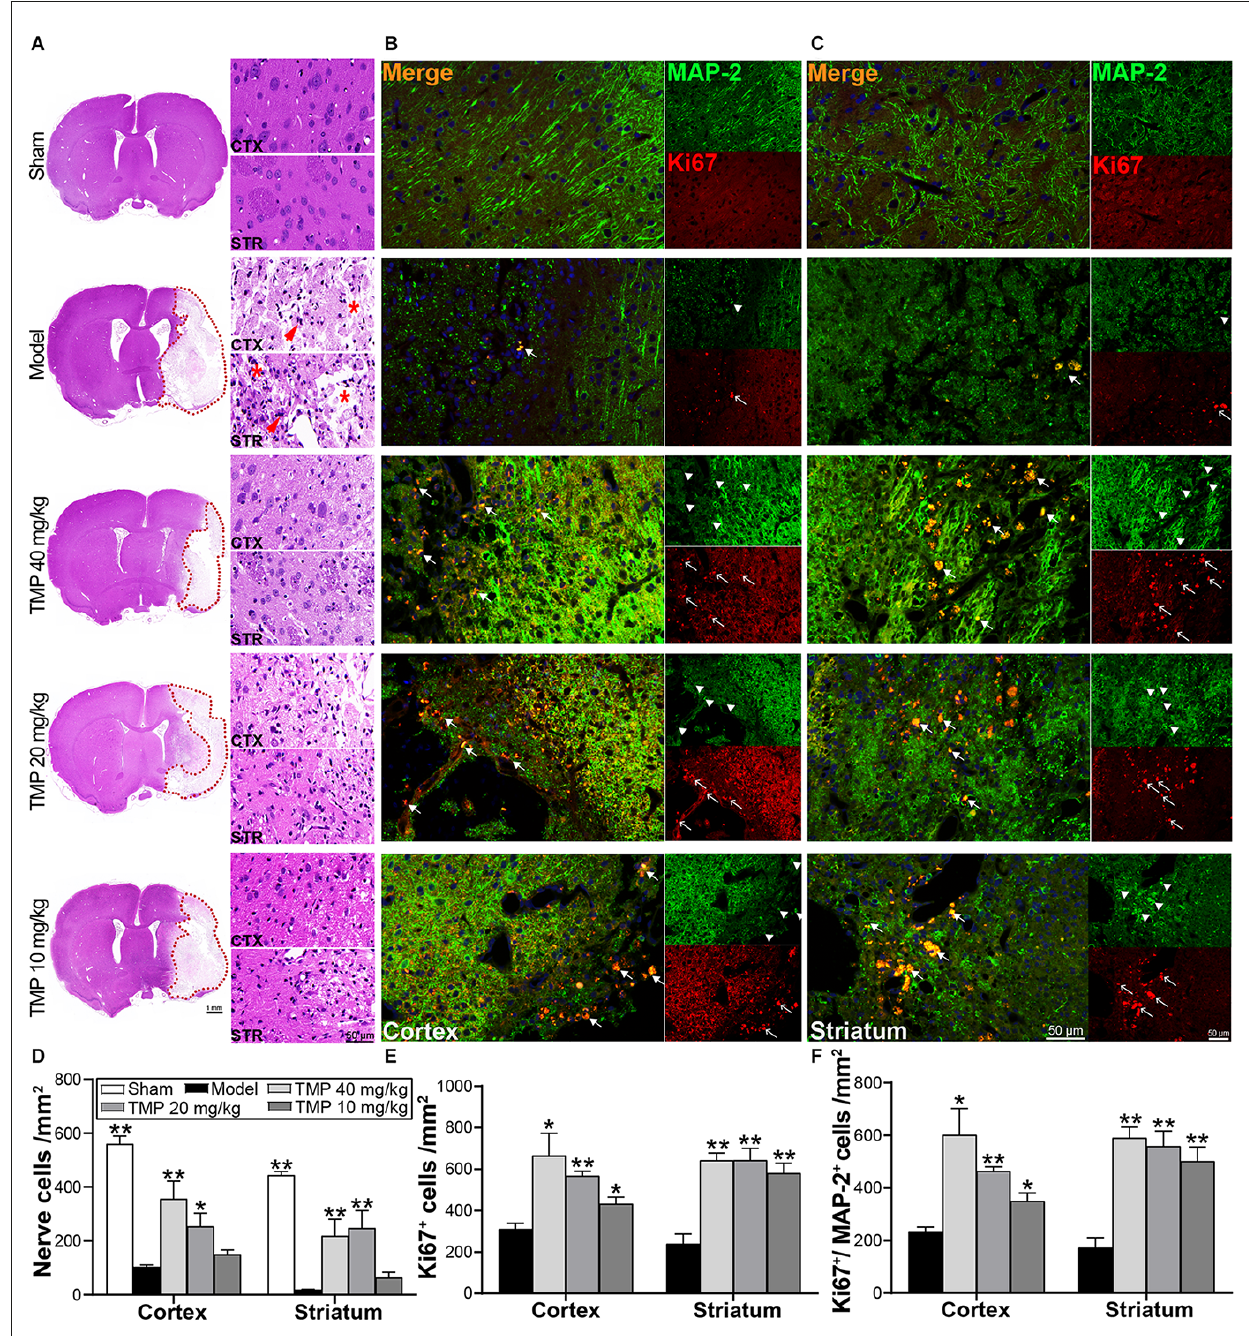
FIGURE3 TMP improved endogenous neurogenesis of MCAO rats. (A) HE staining photographs showed nerve cells in the periinfarct cortex (CTX) and striatum (STR; n = 4). The infarctions were represented with red dotted lines. Abnormal nerve cells (red arrows) and disintegrated tissues (*) were indicated in theModelgroup. (B,C) Immunofluorescenceimagesshowedco-localizationofMAP-2-stainedmatureneurons(green,arrowheads)andKi67-stained proliferative cells (red, empty arrows) in peri-infarct cortex and striatum ( n = 4). Merge (orange, arrows) indicated Ki67/MAP-2 co-labeling cells. DAPI (blue) indicated cell nuclei. Quantification of (D) nerve cell density, (E) Ki67 + cells, and (F) Ki67 + /MAP-2 + cells in the periinfarct cortex and striatum of each group. * P < 0.05, ** P < 0.01 vs. Model group.